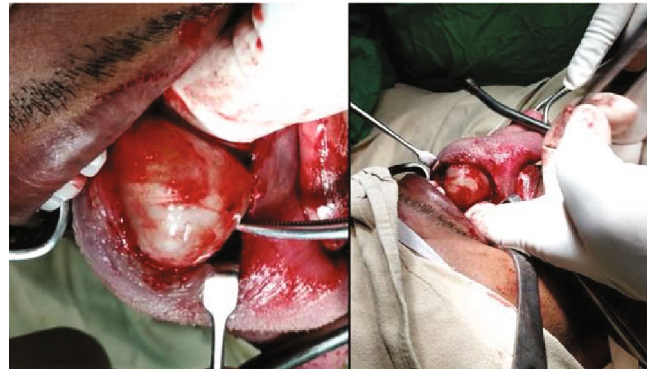
Figure 4: Tumor is being removed from the base of the